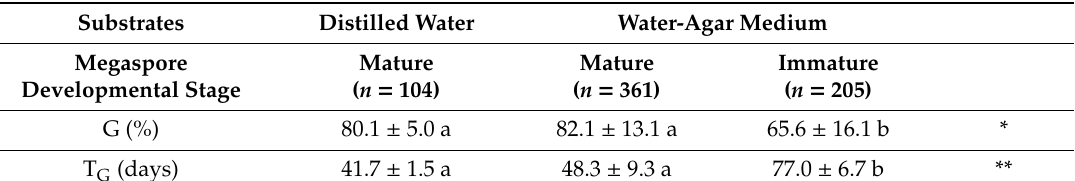
Table 1. Germination percentage (G) and time for the first germination (T G ) of megaspores of Isoëtes sabatina in distilled water and water-agar cultures. All values are reported as mean ± SD; values followed by the same letter are not significantly di ff erent at the 5% level of probability, as determined by Dunn’s test. Significance determined by the Kruskal–Wallis test is reported in the last column as follows, **: 0.001 < p < 0.01; *: 0.01 < p < 0.05.